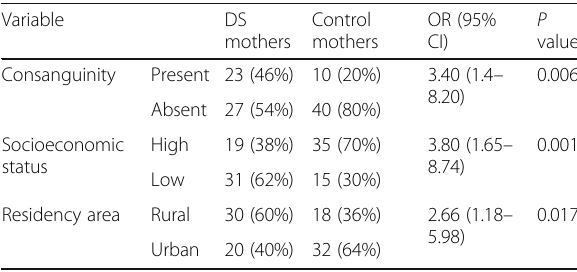
Table 1 Demographic data of young mothers with DS in comparison to control